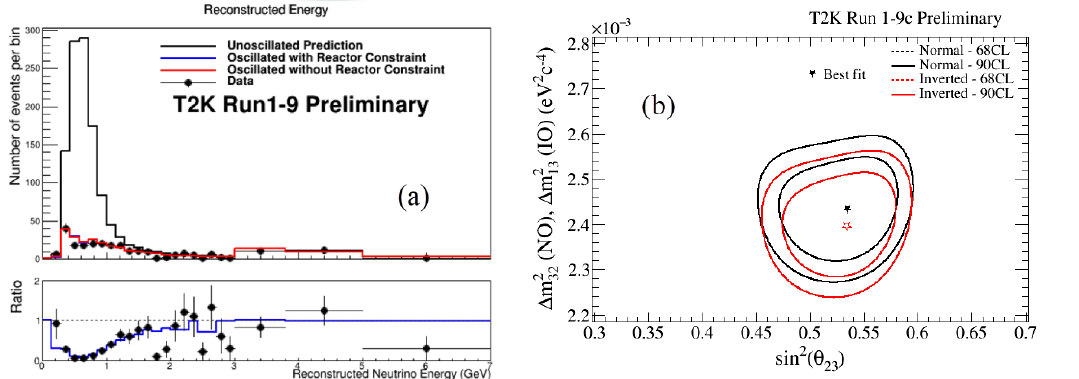
Figure 5. The rate of muon–neutrinos observed in the far detector is significantly suppressed due to neutrino oscillation. ( a ) The expected rate without neutrino oscillation (unoscillated prediction) is compared to the observed rate. Also shown are expected rates for the best fit oscillation parameters. There is no observable difference if reactor data is included in the fit. ( b ) Confidence intervals for the atmospheric oscillation parameters are shown separately for the normal and inverted mass ordering